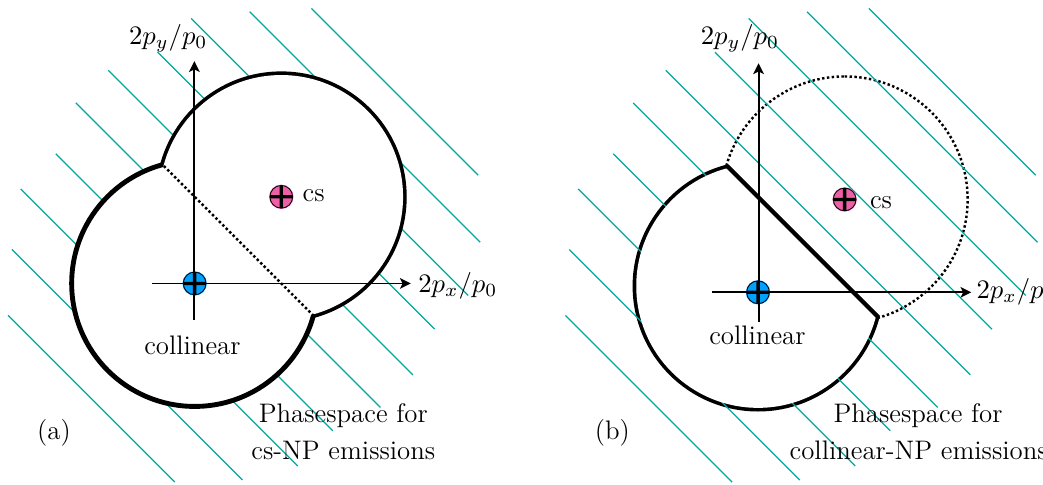
Figure 9 . (a) When the collinear-soft ( cs ) function passes soft drop, the non-perturbative (NP) emissions, with the angular scaling of the cs mode, with a virtuality (cid:3) QCD must fall in the phase space shown by the blue shaded area in order to contribute to q T . (b) When the cs function fails soft drop, the NP emission with the angular scaling of the collinear modes must not be clustered with the collinear sub-jet in order to contribute to q T